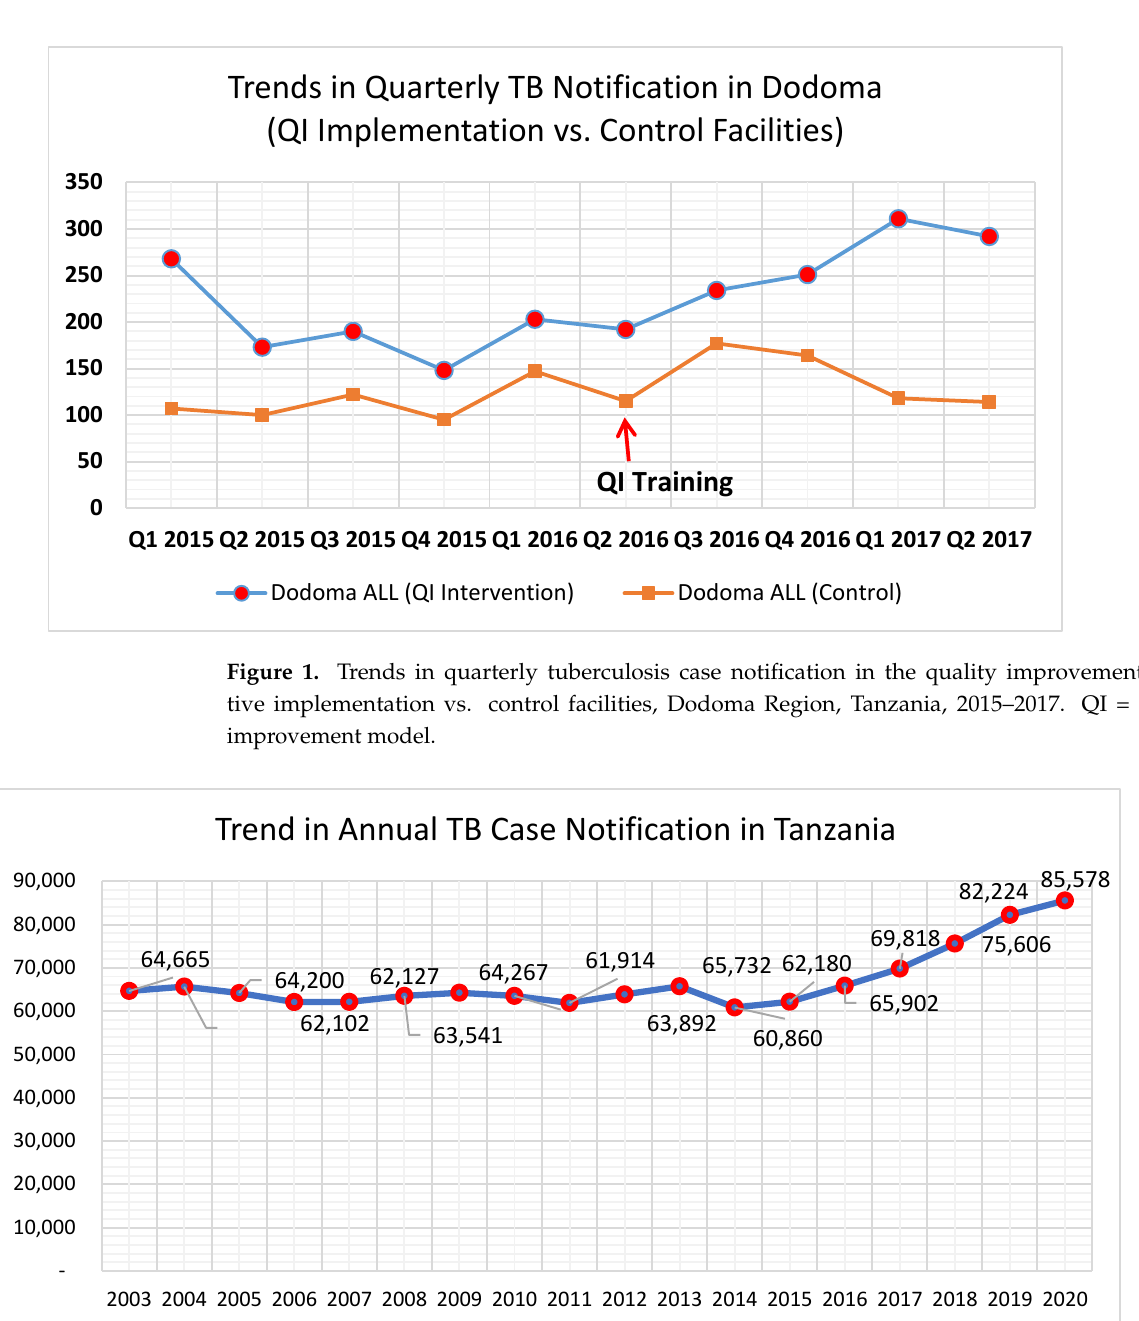
Figure 2. Trend in annual tuberculosis case notification between pre-quality improvement initiative implementation (2014–2015) and the initial pilot and subsequent scale-up of the initiative (July 2016–2017), Tanzania.